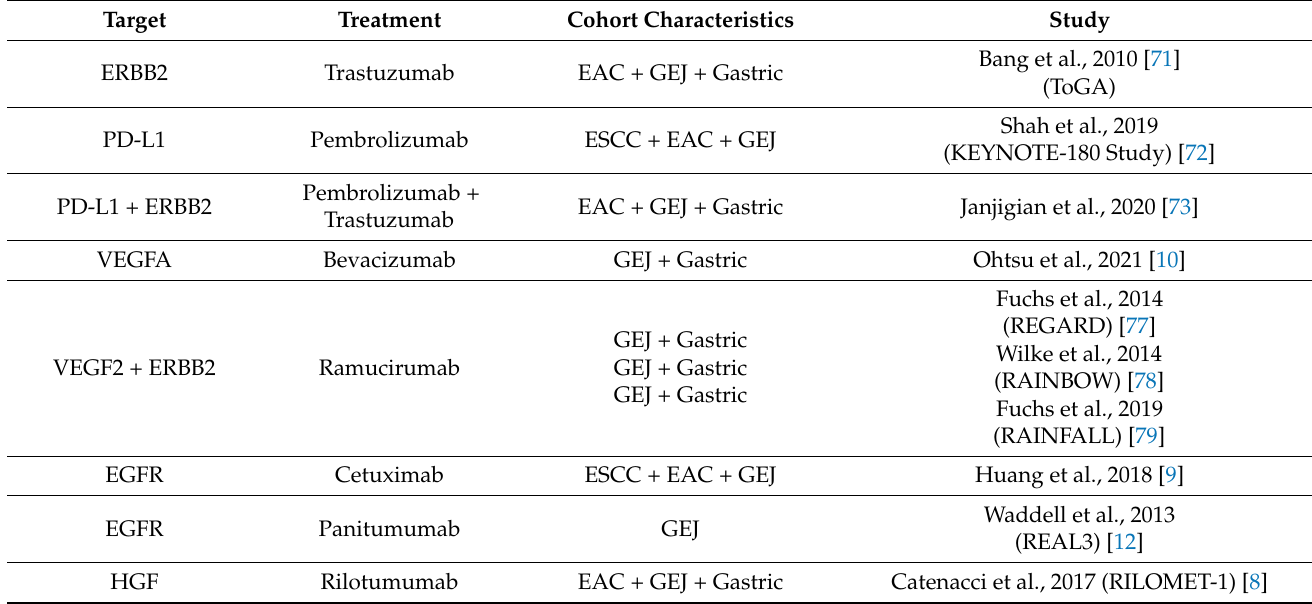
Table 3. Current approaches for targeted therapy in EAC (and other adenocarcinomas of the upper gastrointestinal tract) based on molecular